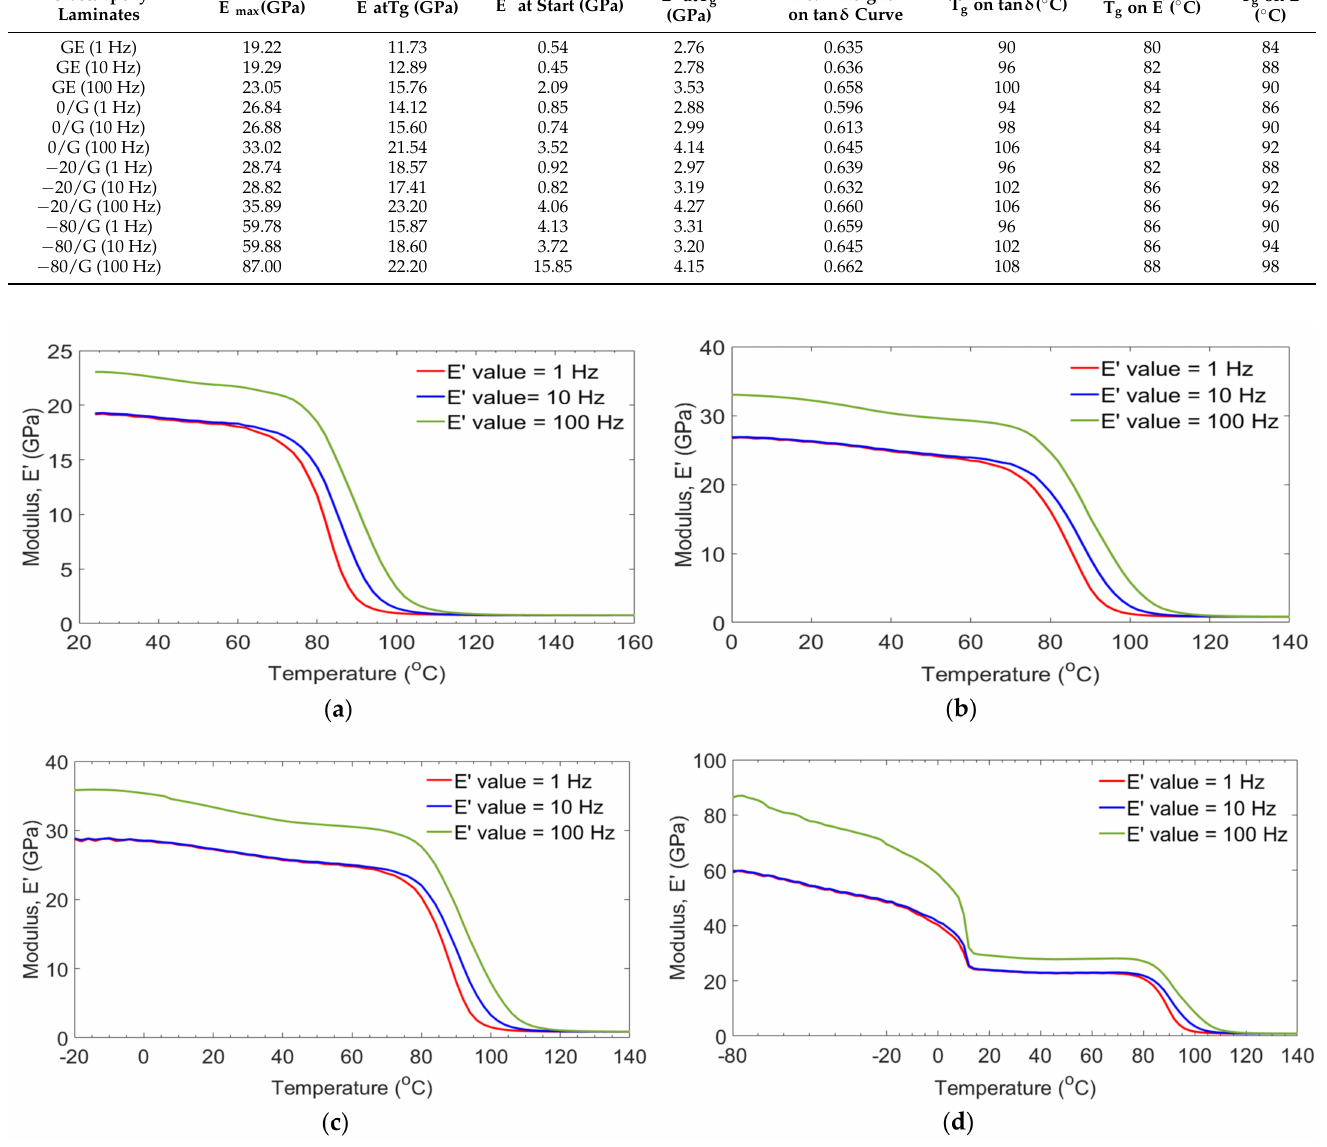
Figure 5. Storage modulus with temperature of GE control ( a ), 0/G ( b ), − 20/G ( c ), − 80/G ( d ) laminates. Figure 6 shows the comparison between the storage modulus results obtained at a frequency of 1 Hz and 100 Hz on control (GE), 0/G, − 20/G, and − 80/G laminates as a function of temperature. As can be seen from the figures, the storage modulus of all laminates increased as the frequency changed from 1 Hz to 100 Hz. Compared with storage modules of control, 0/G, − 20/G, and − 80/G at a testing temperature of 80 ◦ C, the storage modulus increased by 57.45%, 52.47%, 36.15%, and 30.40% when the frequency changed from 1 to 100 Hz. The gaps between the cross-linking of the epoxy matrix might be tended to close when the frequency increases. No frequency difference between all laminates that existed below the decomposition temperature might be due to the damaging of the fiber/epoxy resin